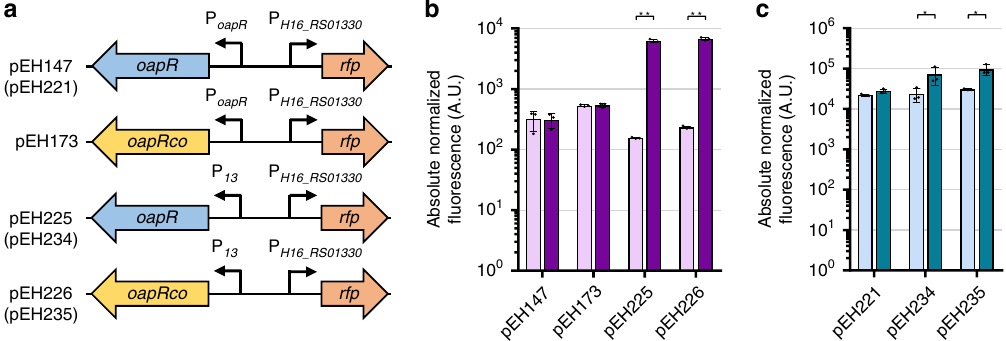
Fig. 4 Engineering the β -alanine-inducible system. a Schematic illustration of the different versions of the β -alanine-inducible system and their corresponding plasmid identi fi ers. Absolute normalised fl uorescence of b E. coli and c P. putida carrying different versions of the β -alanine-inducible system – reporter construct in the absence (light purple and light blue) and presence (dark purple and dark blue) of 5 mM β -alanine. Single time-point RFP fl uorescence measurements were taken 6 h after effector addition. Data are mean ± SD, n = 3, * p < 0.05, ** p < 0.0001, unpaired two-tailed t -test. Source data are provided as a Source Data fi